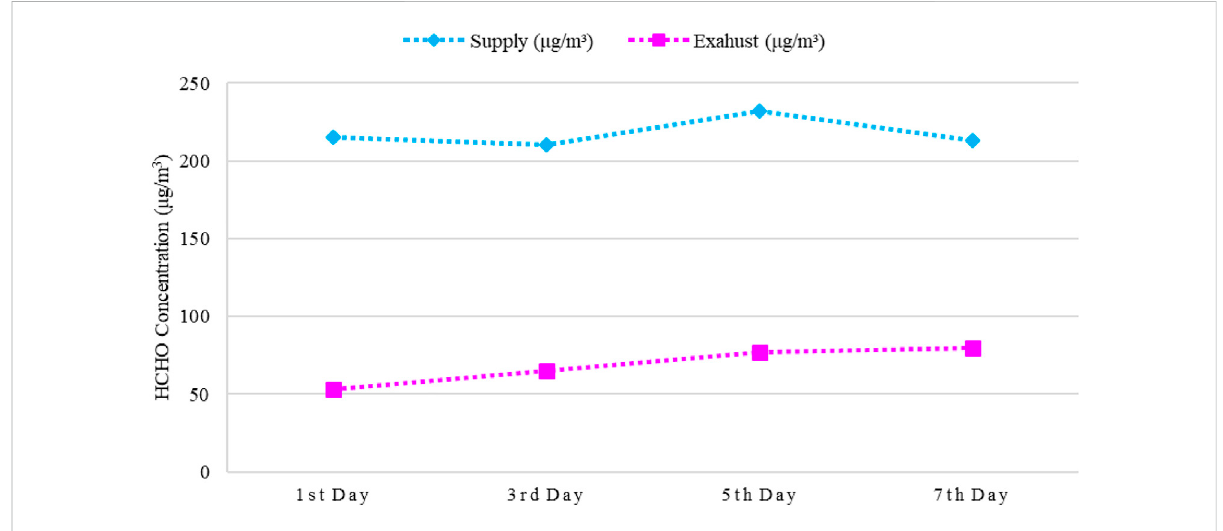
FIGURE 6 HCHO Adsorption Test Result (Normal wallpaper with 10 wt%).